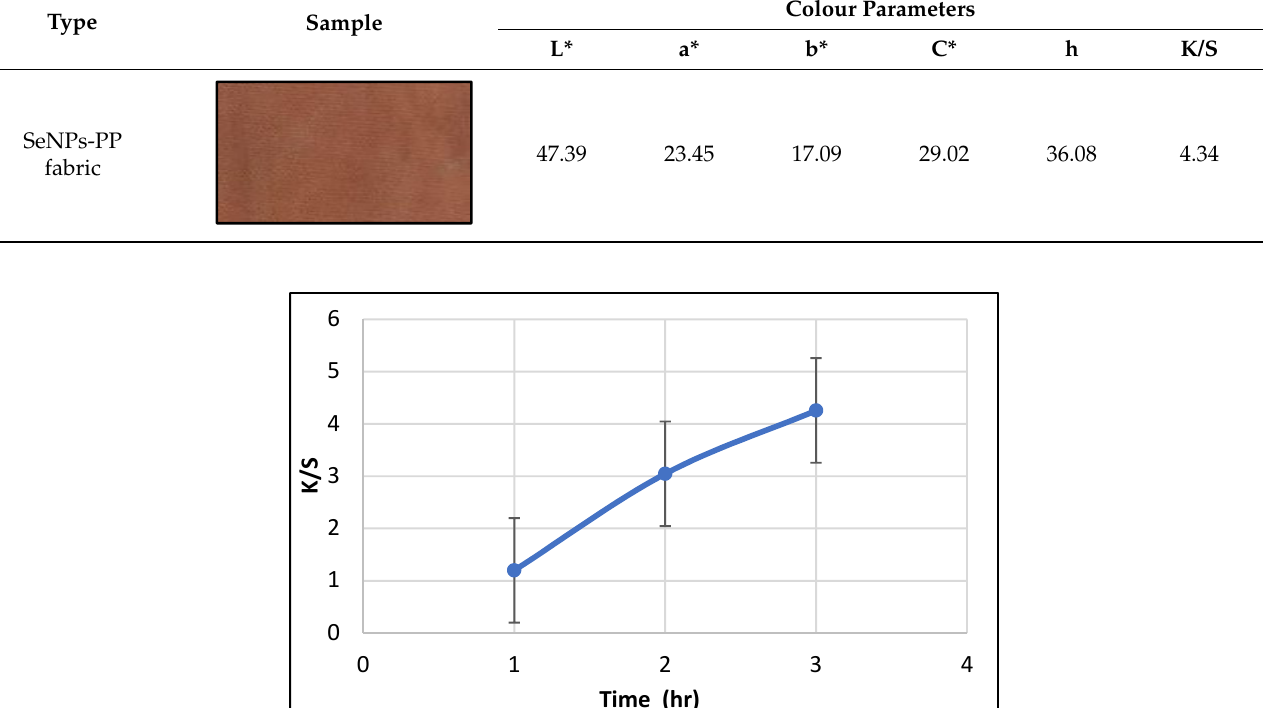
Figure 6. Lab colour space. Table 1. Optical measurements.